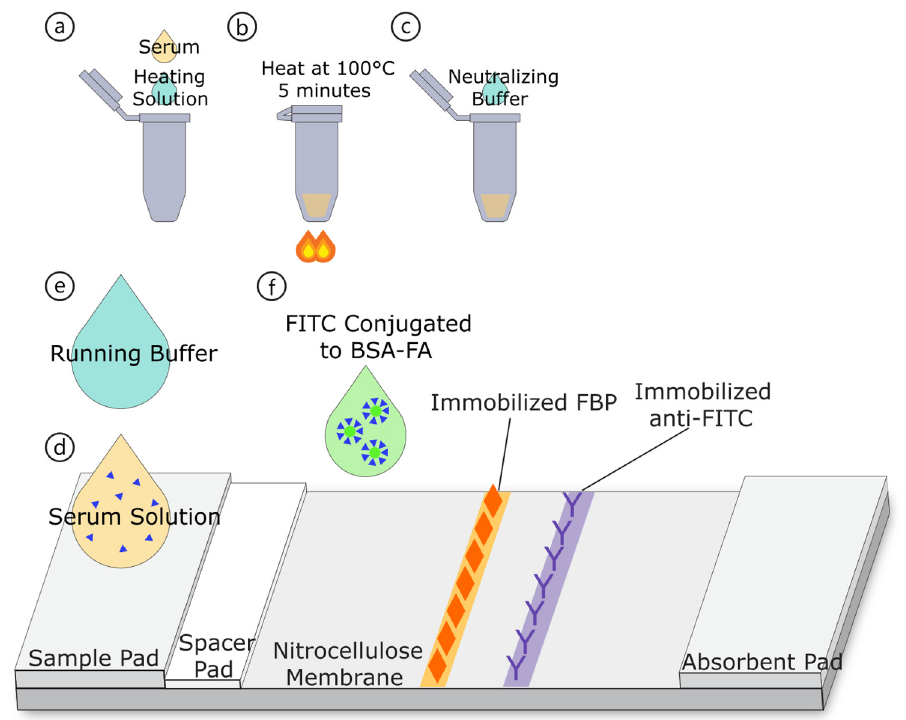
Fig 1. Schematic of sample processing and lateral flow assay. (a) Combination of serum sample with high-pH buffer. (b) Heating of serum solution. (c) Addition of acidic buffer to lower pH. (d) Application of prepared serum solution to LFA. (e) Application of running buffer. (f) Addition of FITC conjugates to nitrocellulose